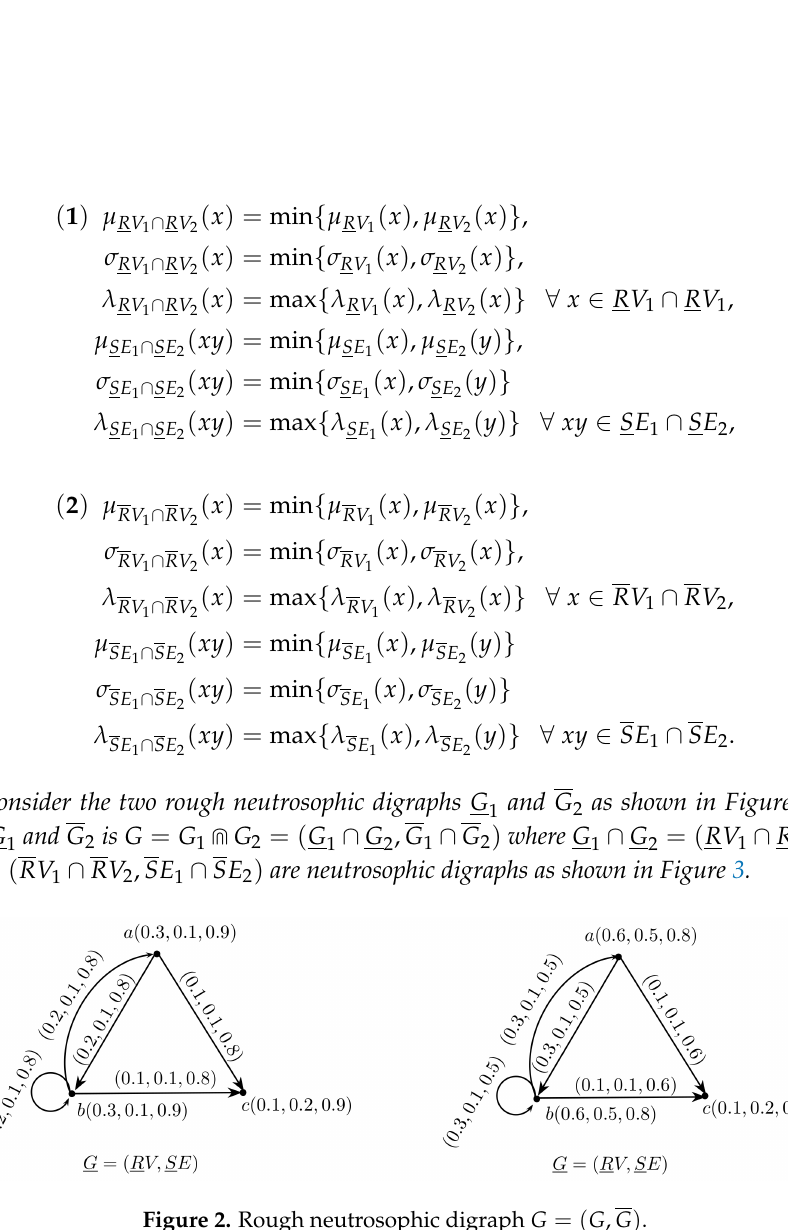
Figure 2. Rough neutrosophic digraph G = ( G , G ) .